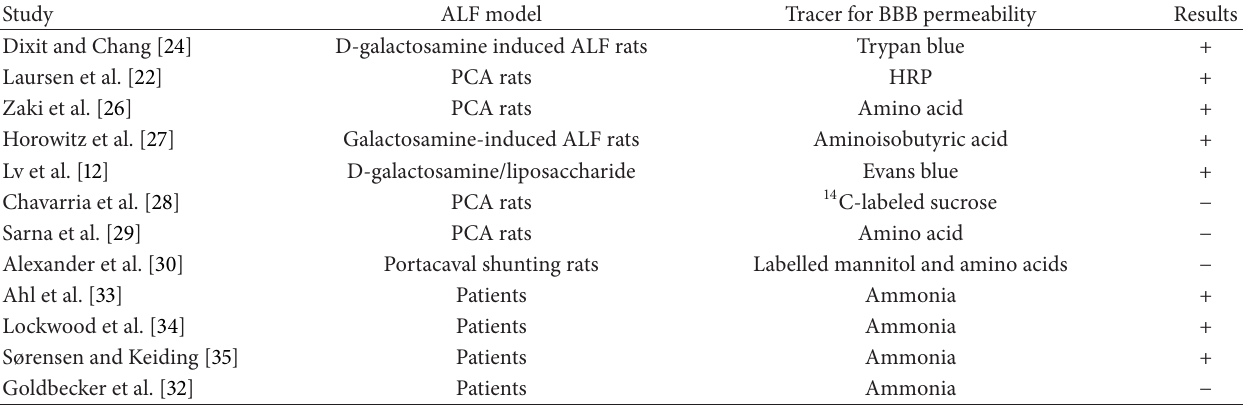
Table 1: Different studies on BBB penetration by different compounds in